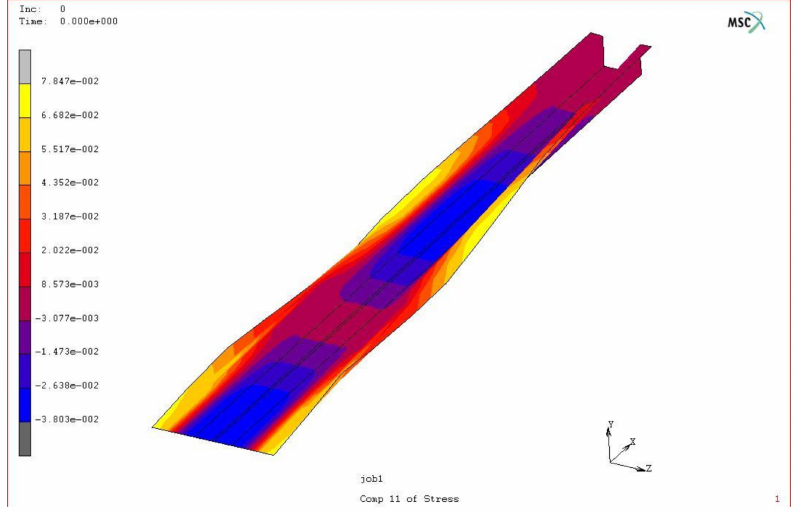
Figure 8. A cloud diagram of the mean longitudinal strain from the 1st to 12th